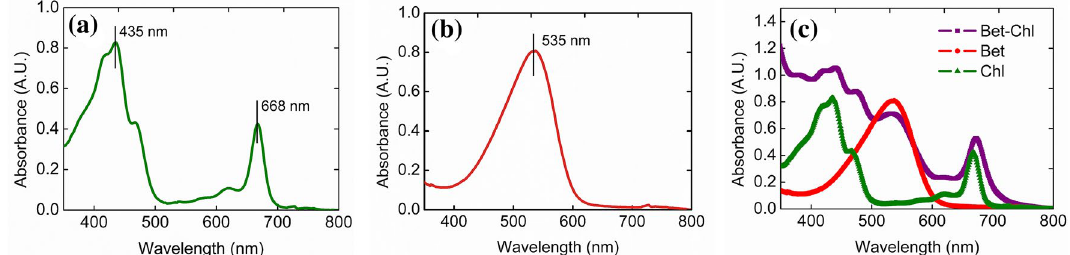
Fig. 2 Absorption spectrum of a chlorophyll- a , b betanin and c betanin–chlorophyll 1:1